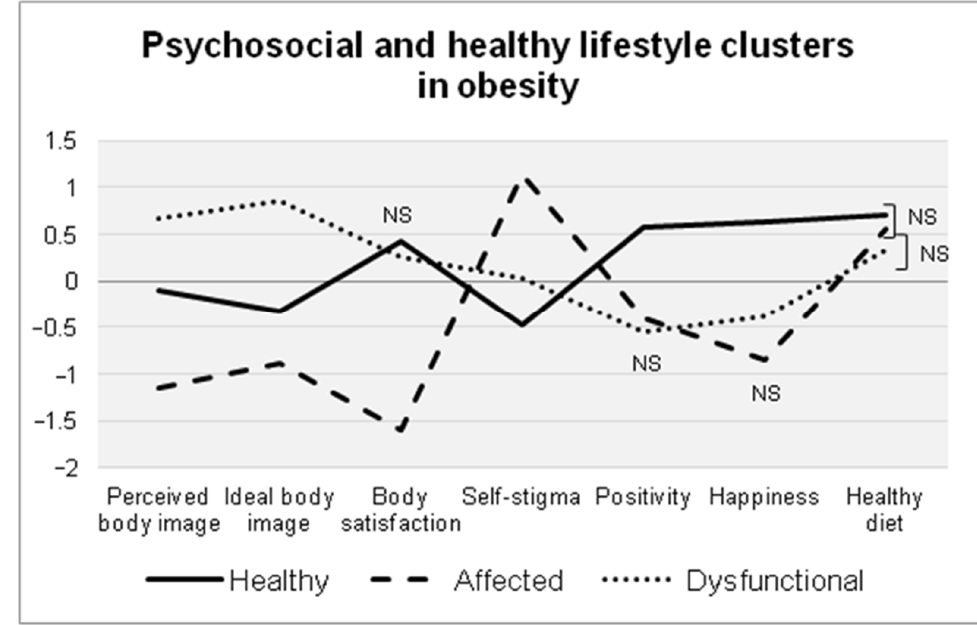
Figure 1. Graphical representation (centroids) of the psychosocial and healthy diet profiles identified in the cluster analysis. All the differences were significant at p < 0.05; NS = Non-significant difference ( p > 0.05).